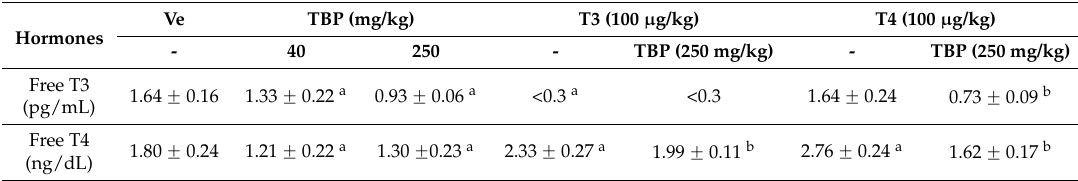
Table 1. Free triiodothyronine and free thyroxine levels in